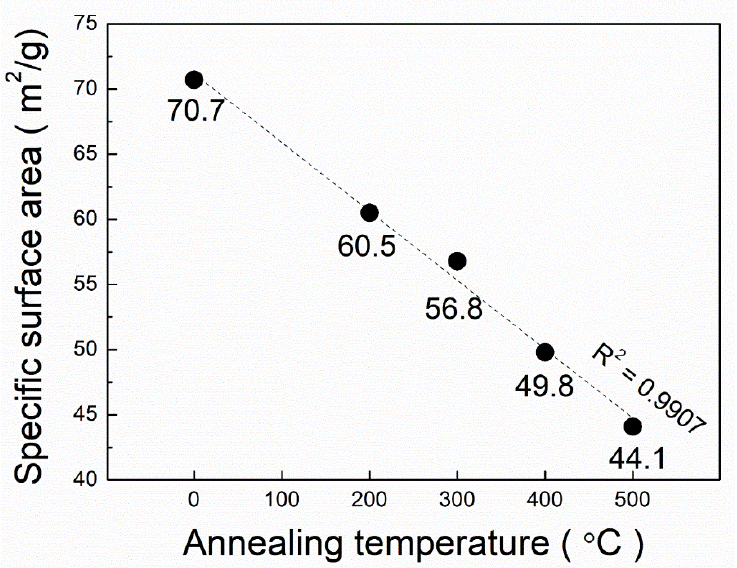
Figure 3. Variation of the specific surface areas of PTNTs annealed at 200, 300, 400, and 500 °C for 1 h, respectively.